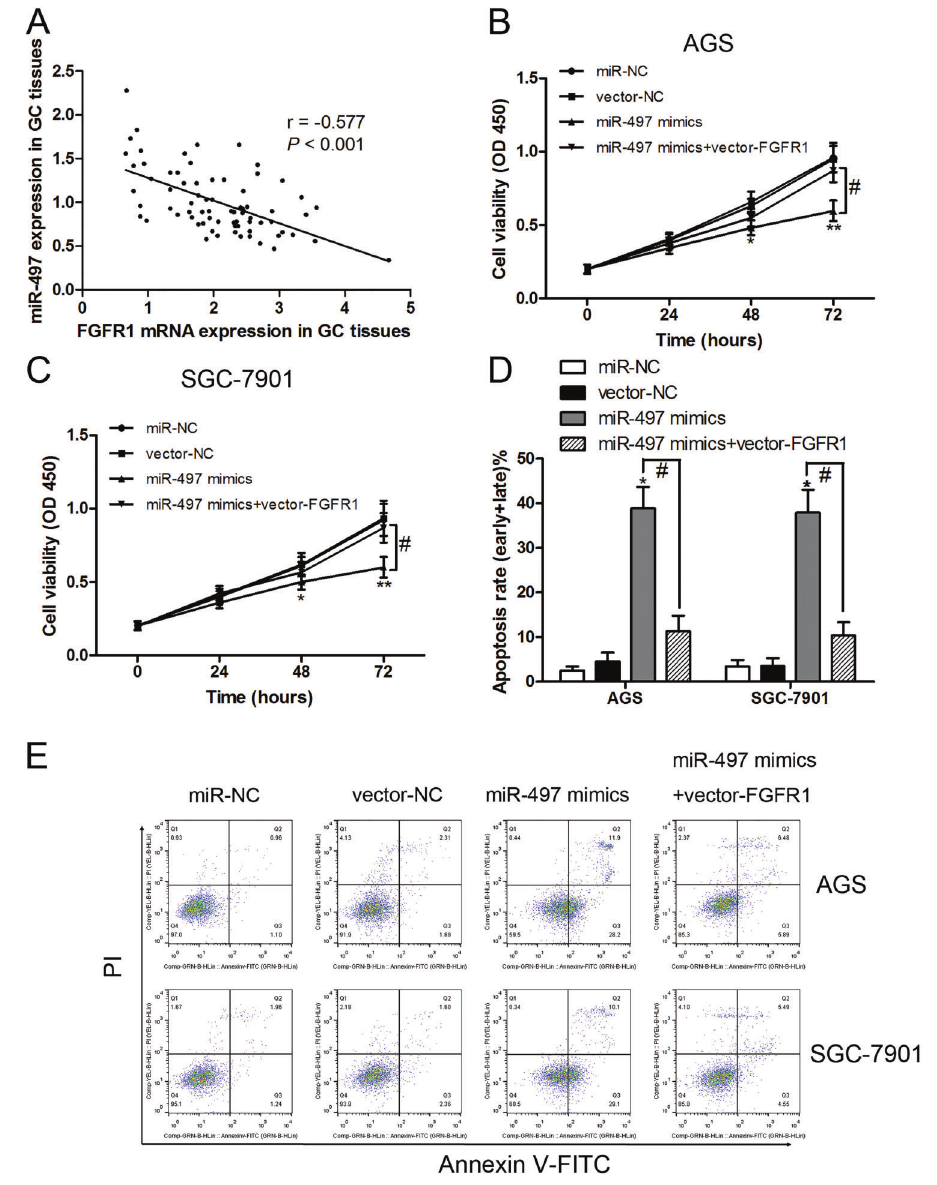
Figure 5. Correlation between miR-497 and fi broblast growth factor receptor 1 (FGFR1) by Spearman ’ s rank correlation analysis ( A ). After transfection with miR-497 mimics or miR-497 mimics combined with vector-FGF1, cell viability was measured by CCK-8 assay ( B and C ), and cell apoptosis was detected by fl ow cytometry in AGS and SGC-7901 cells ( D and E ). Data are reported as means ± SE. *P o 0.05, **P o 0.01; # P o 0.05 (ANOVA, n=3 in each